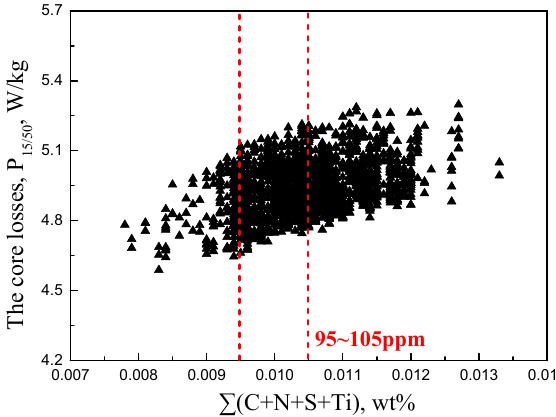
/ kg) and (cid:80) (C + N + S + Ti)